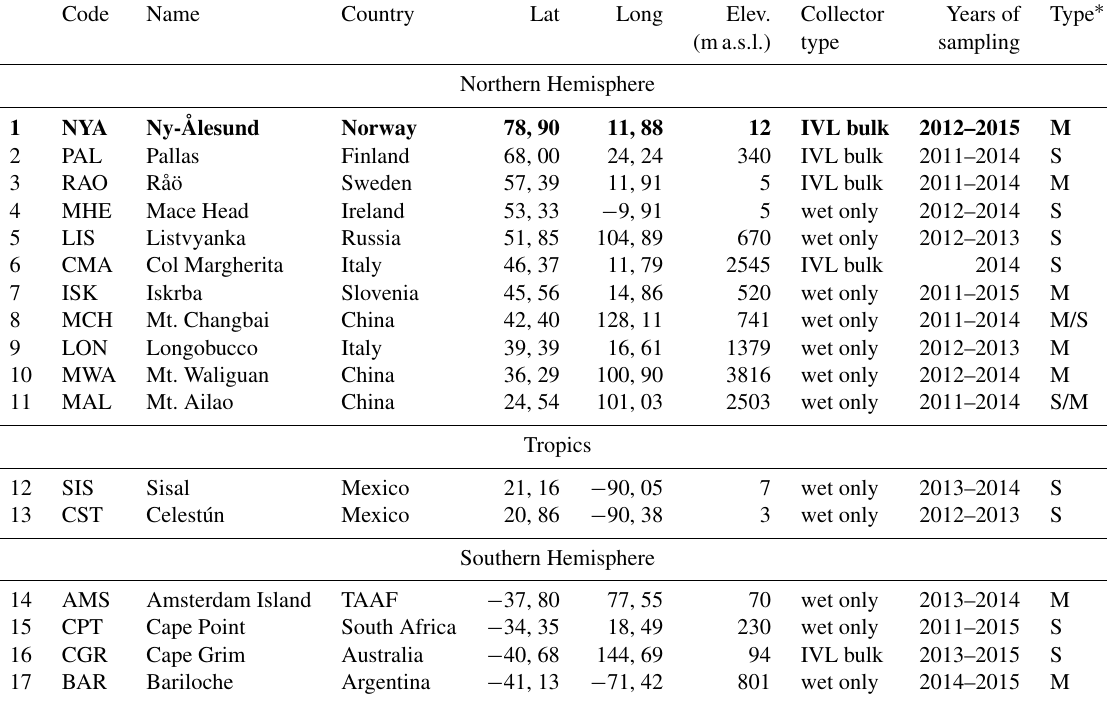
Table 1. Station locations that are part of the GMOS network and general characteristics of the sites (i.e., code, name, country, latitude, longitude, elevation), including the years of sampling as well as the type of monitoring stations with respect to the Hg measurements carried out as speciated (M) or not (S). M/S or S/M indicates change of the site from master to secondary or vice versa. External GMOS partners are indicated in